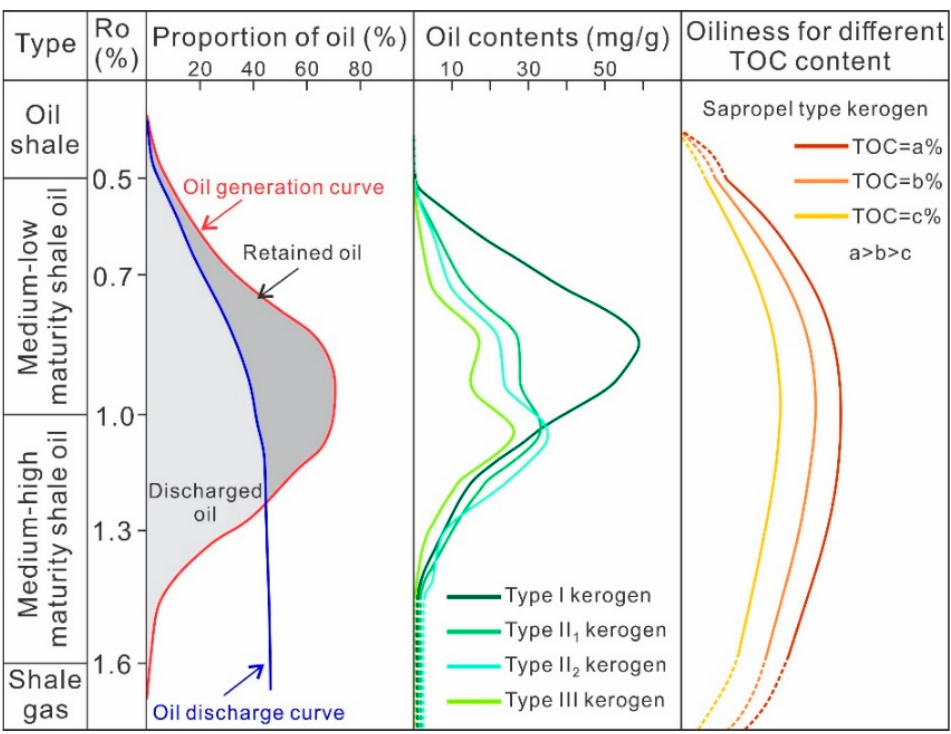
Figure 2. Oil-bearing characteristics of shales with different organic matter type, content, and maturity. Modified after [9,57–59].